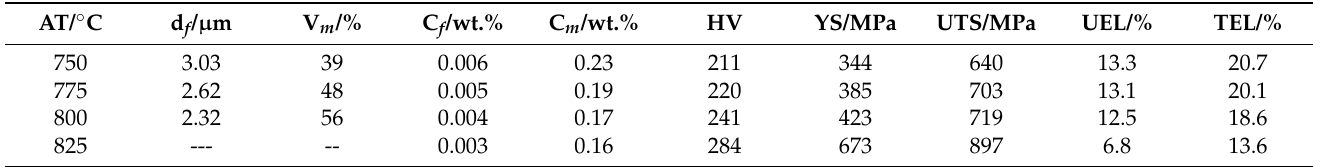
Table 1. Microstructure parameters and mechanical properties of LH800 steel at various austenitizing